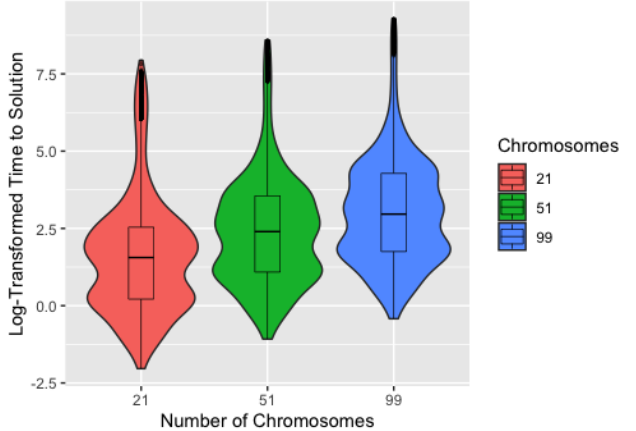
Figure 7. Boxplots and violin plots for log time to identify a solution (in seconds) by number of chromosomes for 200 generations without